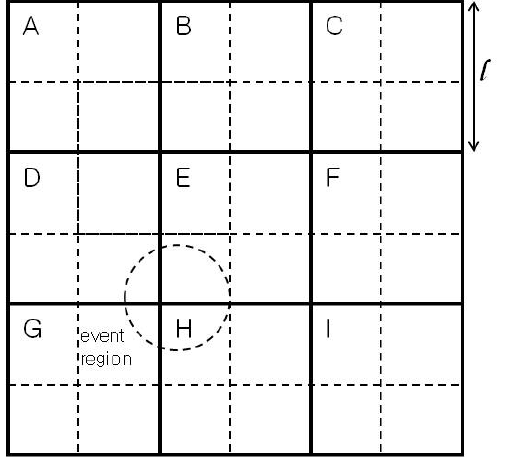
Figure 1. Sensor network structure for fault-tolerant event